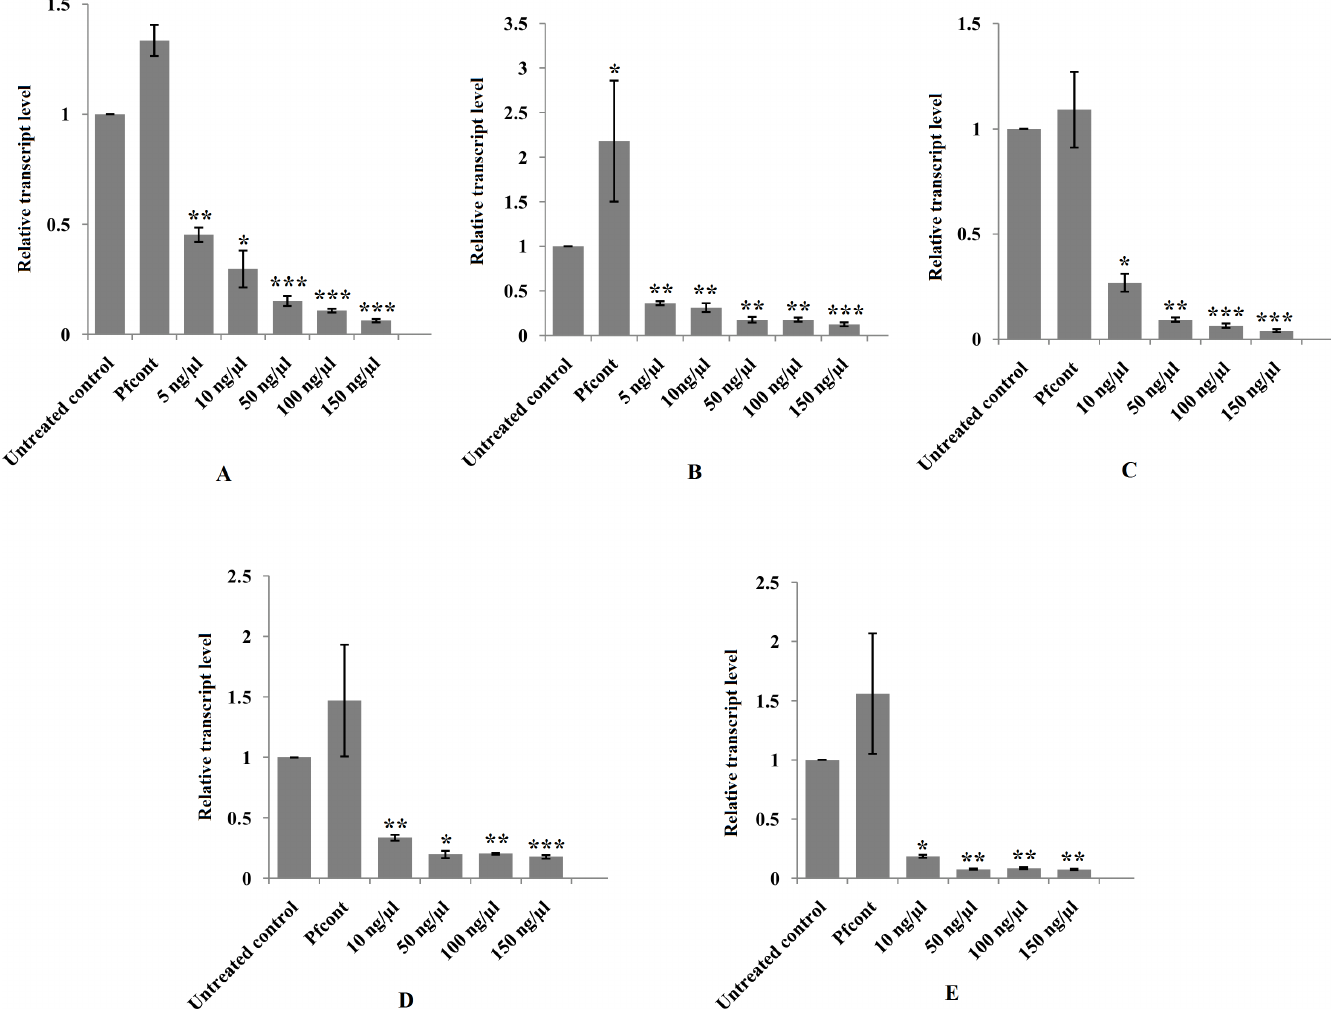
Fig 3. Relativetranscript levels of SOD (A), σ GST (B), CatL1-D (C), Cat B1-B3 (D) and Cat B2 (E) genes showingdsRNA concentration dependent suppression of the mRNA transcript at 72 h post-RNAi. Results are presented as the mean ± standard error (SE) of the unit value of 2 −ΔΔ Ct from three independentexperiments. P values of (cid:20) 0.05 were consideredsignificant.Experiments were repeated (cid:21) 3 times. Significantdifferences betweendsRNA treated and untreatedcontrol worms are indicated( * , P < 0.05; ** , P < 0.01; *** , P < 0.001).(Pfcont = P . falciparum negativecontrol).